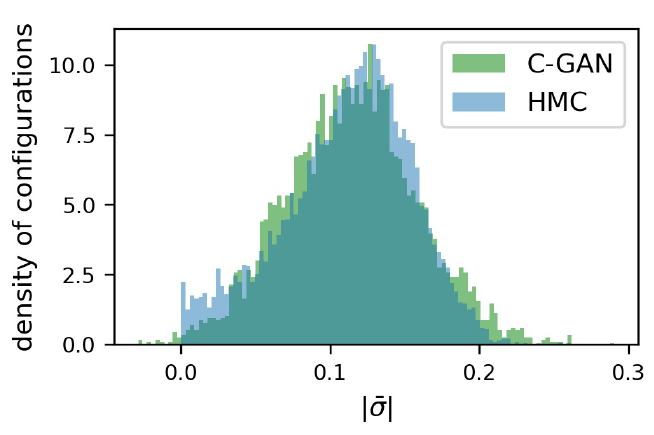
Figure 8: Histogram of | ¯ σ | at λ = 1.6 ∈ Λ quite well.